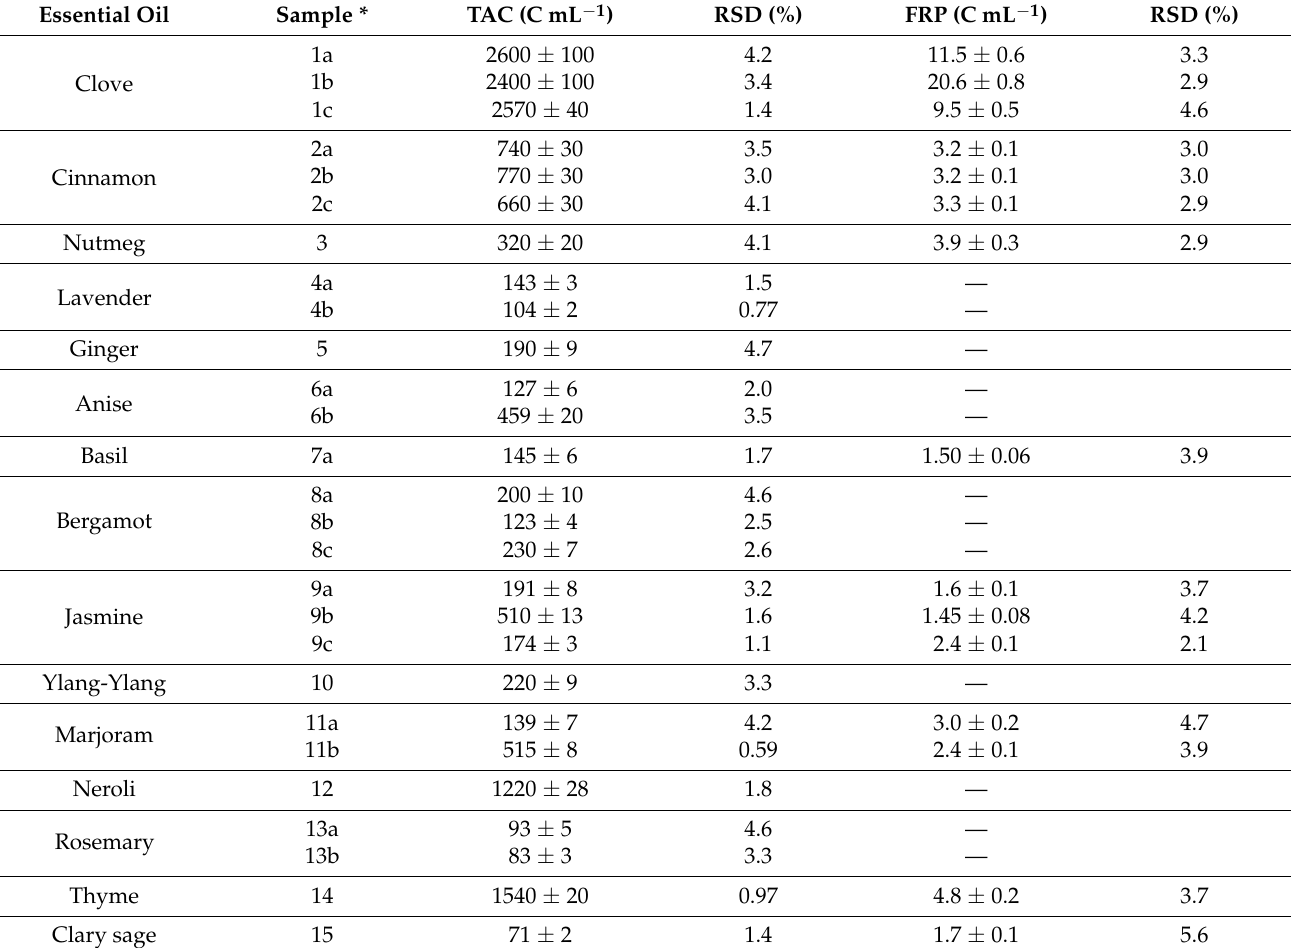
Table 3. Total antioxidant parameters of the essential oils based on the coulometric titration data ( n = 5; p =